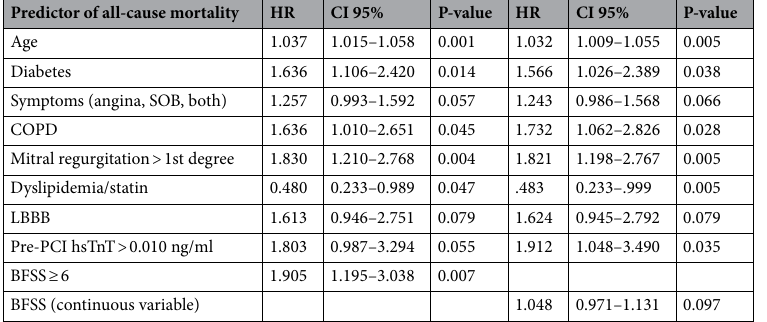
Table 5. Independent predictors of all-cause mortality on multivariate analysis. PCI percutaneous coronary intervention, hsTNT high sensitive troponin T, BFSS bifurcation functional significance score.